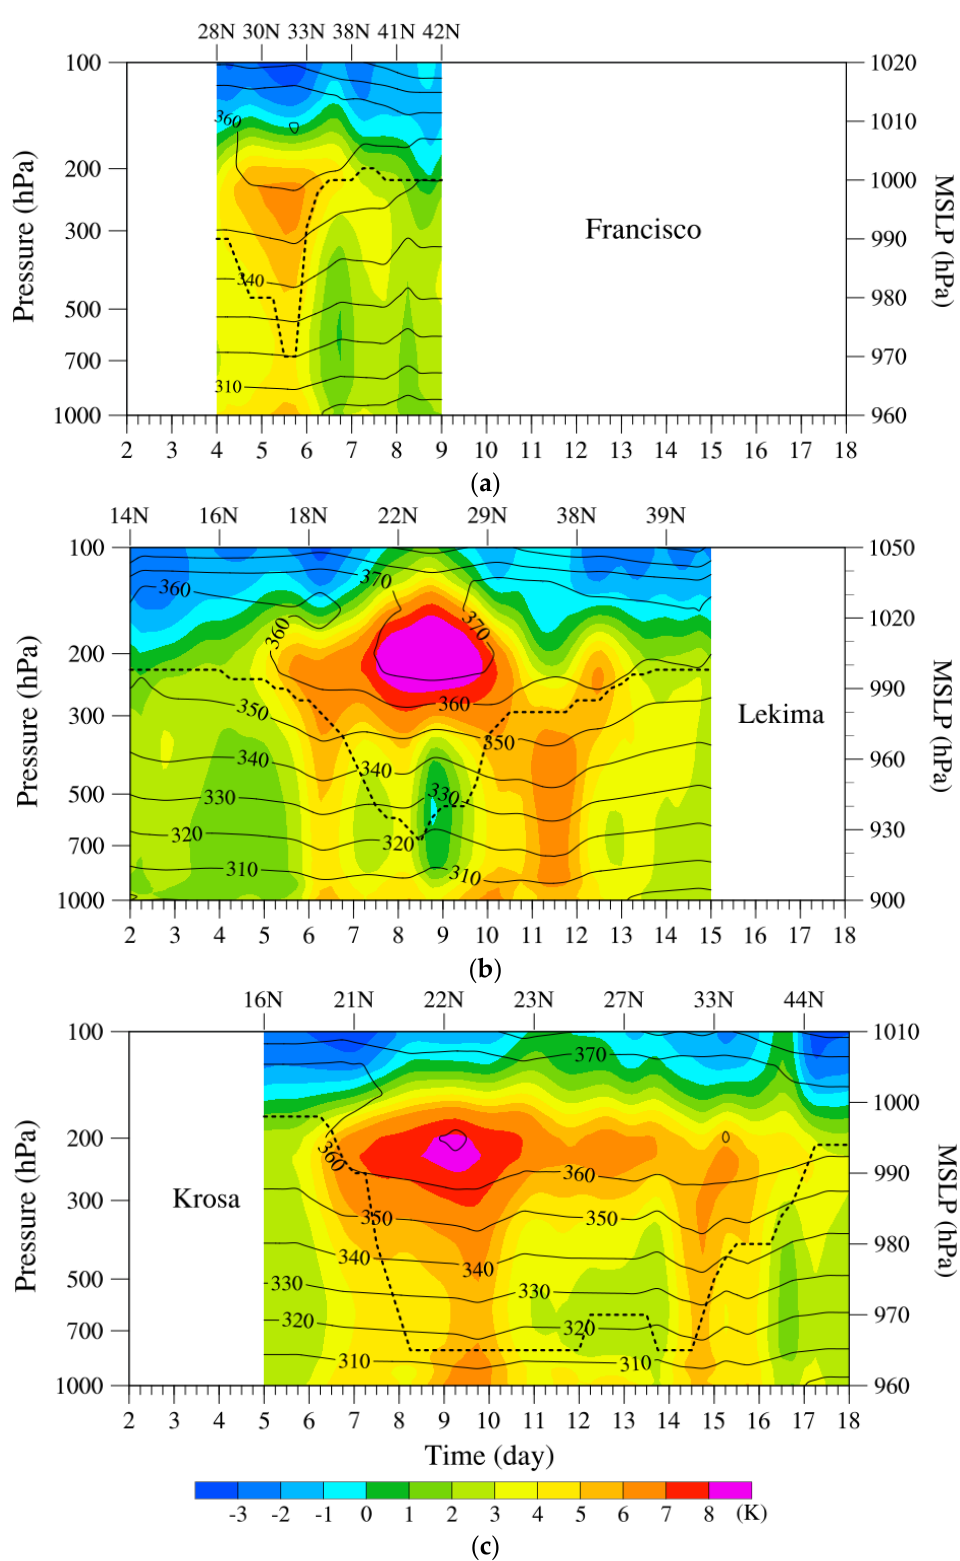
Figure 15. Temporal evolutions of the vertical variations in FY-3D MWTS-2 temperature anomalies (shaded) and potential temperatures (contour) at the typhoon centers of ( a ) Francisco, ( b ) Lekima, and ( c ) Krosa in August 2019. Also shown is the MSLP (black dot curve).